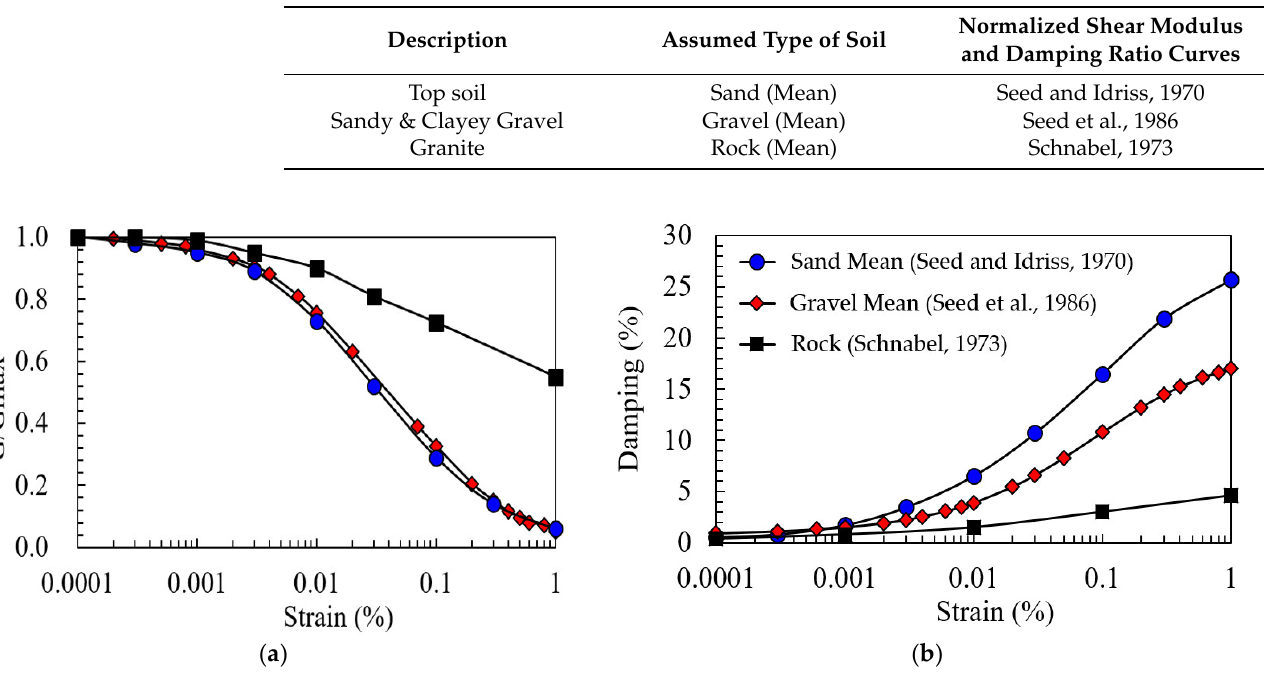
Figure 5. Dynamic soil properties: ( a ) normalized shear modulus reduction curves; ( b ) damping ratio curves.